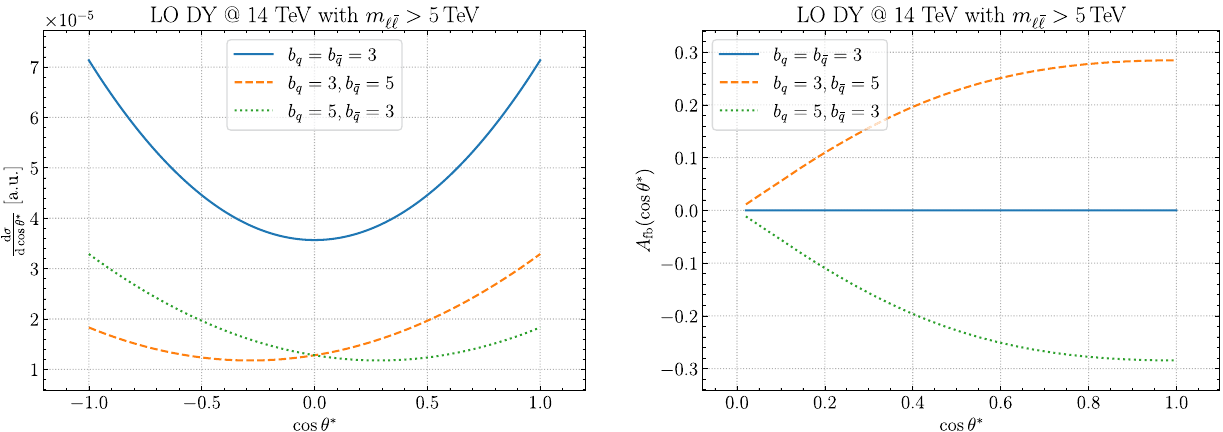
Fig. 6 The single-inclusive cos θ ∗ distribution Eq. (2.17) (left) and the corresponding forward–backward asymmetry (right panel) Eq. (2.22) evaluated using the toy PDFs of Eq. (3.1). No kinematic cuts are applied except for m min